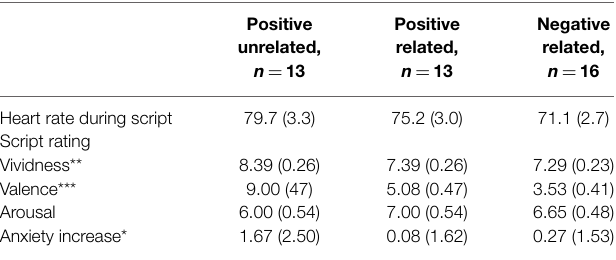
TABLE 1 | Heart rate during scripted imagery, script ratings and subjective anxiety in Experiment 1 ( n = 42)